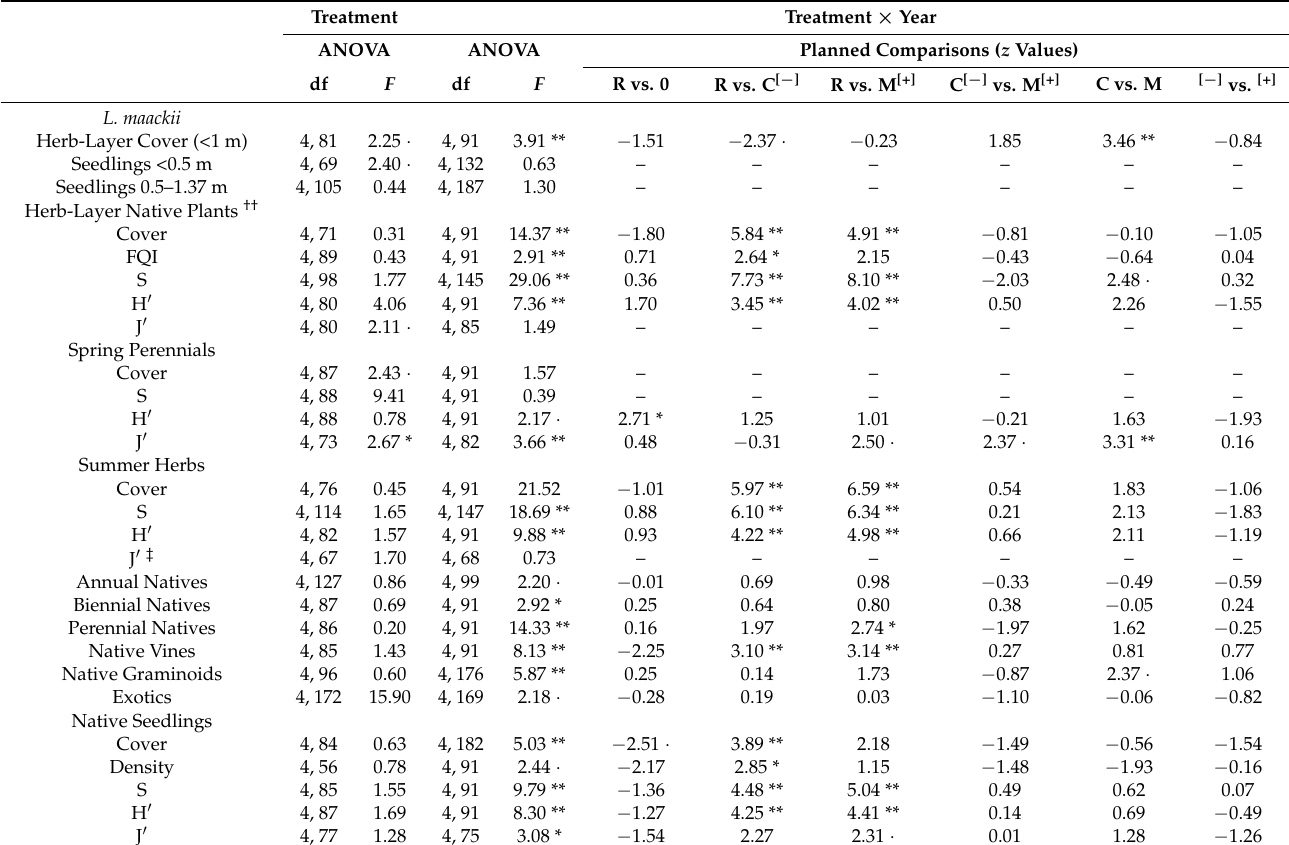
Table 4. Linear mixed effects model results for understory community response metrics to different shrub removal treatments, including richness (S), Shannon’s diversity index (H (cid:48) ), and Pielou’s evenness (J (cid:48) ) each subset of understory taxa, floristic quality index (FQI) for the entire understory community, and cover of herbaceous plant groups based on life history strategy. Treatments included cut-stump (C) or forestry mulching head (M), with mulch ( [+] ) or without ( [ − ] ), and an untreated reference (R). Spring perennial cover data were collected late-April to early-May and all other data were collected mid-July to early-August from 2015 to 2017 at four mature secondary hardwood forest sites near West Lafayette, IN,